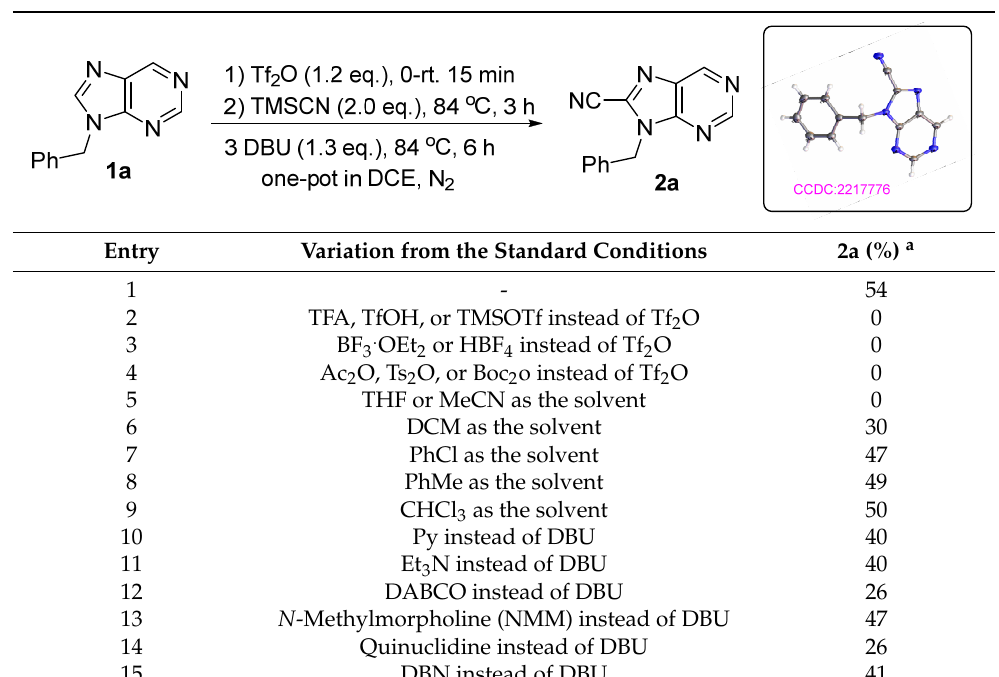
Table 1. Optimization of the cyanation of purine 1a .